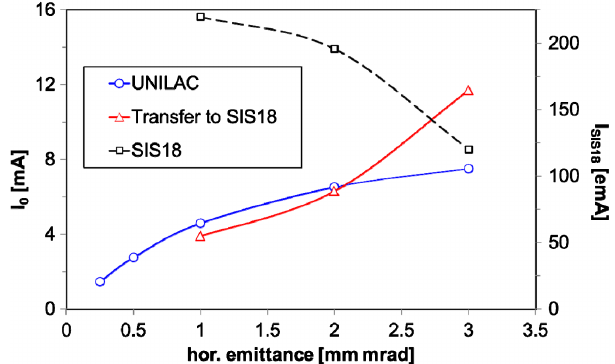
FIG. 5. UNILAC beam current to get in the synchrotron, filling SIS18 up to its space charge limit (red); UNILAC-beam current (measured at 1 . 4 MeV = u; blue) and overall SIS18 beam current (black) as a function of U 28 þ horizontal input emittance at SIS18